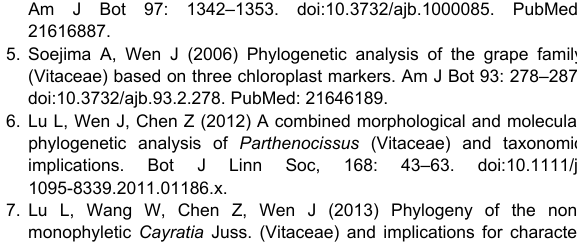
Figure S2. Length distribution of 417 ortholog gene sequences (data include 6672 sequences, the total of 417 genes x 16 samples).